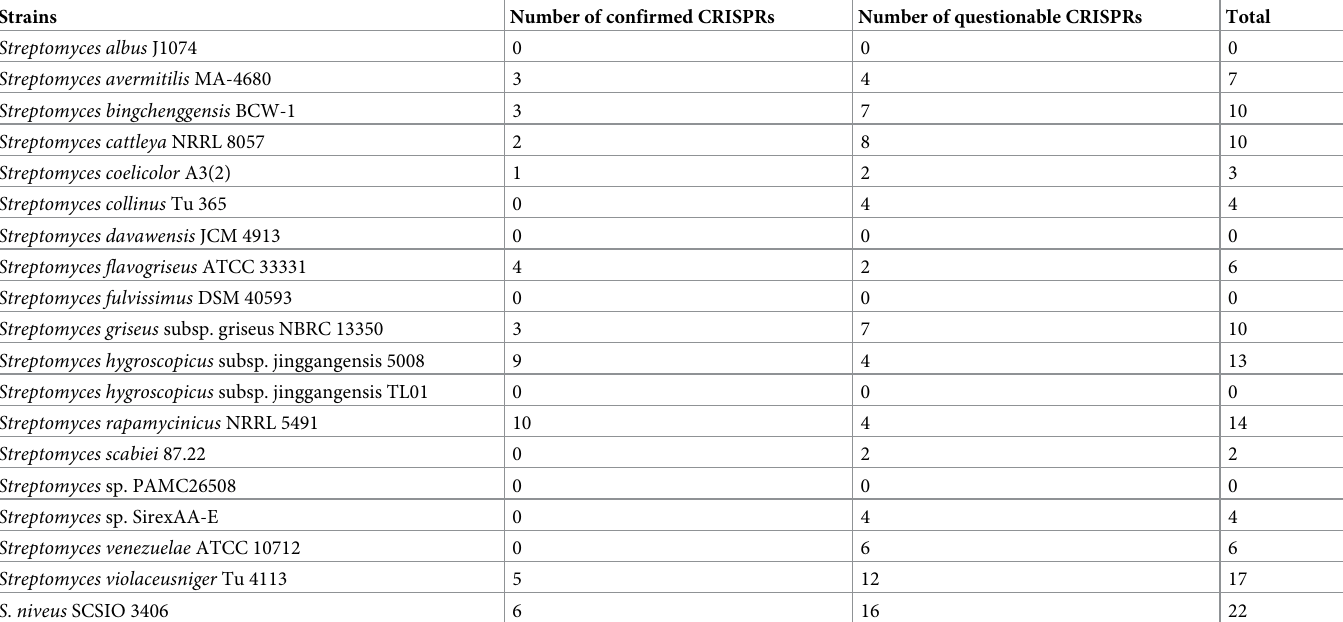
Table 5. Number of CRISPRs in Streptomyces genome.